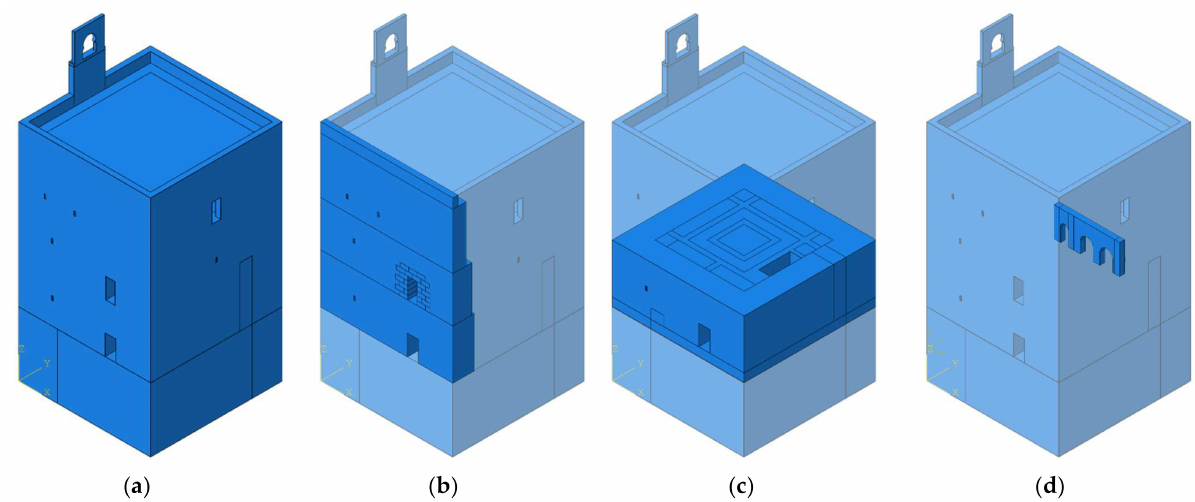
Figure 5. Models created for the loading scenarios: ( a ) full building model; ( b ) simplified façade model; ( c ) Level 2 model; ( d ) interior wall model.